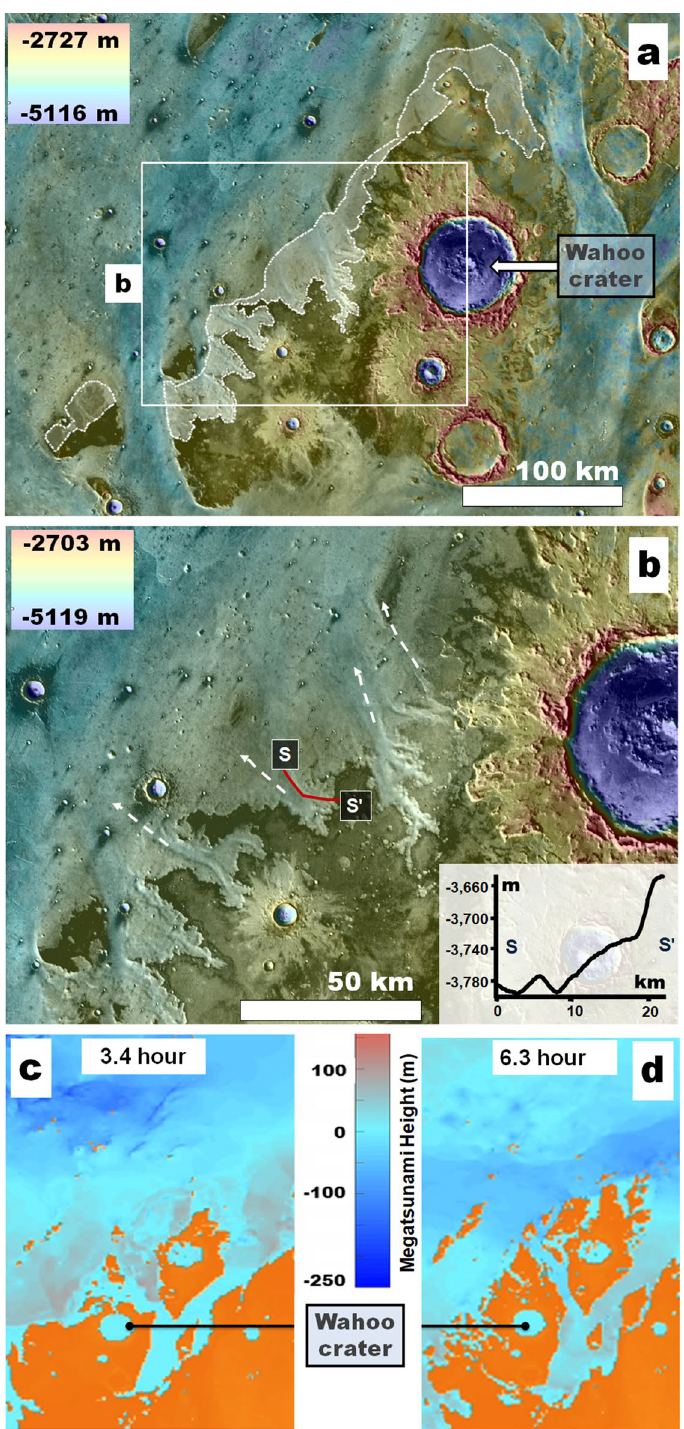
Figure 6. (a) View of an extensive streamlined mesa forming the base of Wahoo crater in Chryse Planitia (Wahoo crater is identified in Fig.1a). The dashed white lines demark channeled slopes facing towards the northern plains. These are mostly not connected upstream to outflow channels. (b) Close-up view on panel ( a ) showing some of the channels (dashed white lines). The elevation profile S-S’ along one of the channels shows a ~ 140 m relief gain ~ over 20 km (~ 0.4°). Panels (a,b) Color MOLA DEM (460 m per pixel, credit: MOLA Science Team, MSS, JPL, NASA) over a THEMIS daytime IR global layer (http:// www. mars. asu. edu/ data/, 100 m per pixel, credit: Christensen, et al. 7 ). (c,d) Parts of simulation in Fig. 5 showing WG movie 1, timesteps 3.4 and 6.4 h. During the time interval, the megatsunami recedes from the Wahoo crater’s northern margin. The predicted backwash happens where the noted channels occur. We produced this figure using Esri’s ArcGIS 10.3 (http:// www. esri. com/ softw are/